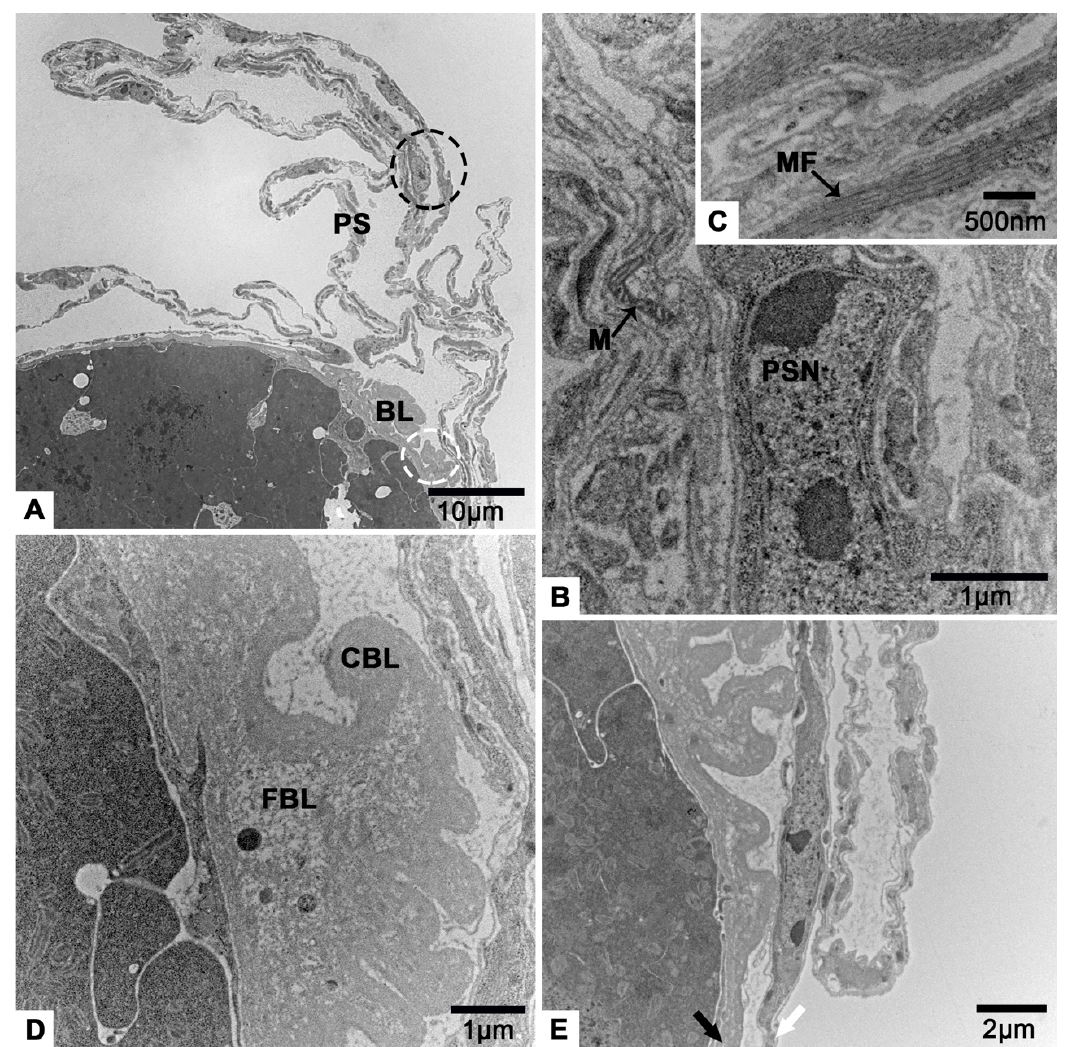
Figure 4. TEM micrographs of the terminal filament of the T. klimeschi ovariole on sixteenth day post-eclosion. ( A ) Longitudinal section of terminal filament. ( B ) An enlarged view of the area shown by the dotted black circle in Figure 4A. ( C ) The myofibrils of peritoneal sheath cell. ( D ) An enlarged view of the area shown by the dotted white circle in Figure 4A. ( E ) The peritoneal sheath (white arrow) and basal lamina (black arrow) become thinner as they extend to the posterior of the ovariole. Peritoneal sheath (PS); basal lamina (BL); nucleus of a peritoneal sheath cell (PSN); mitochondrium (M); myofibrils (MF); compact basal lamina (CBL); and fibrillar basal lamina (FBL).